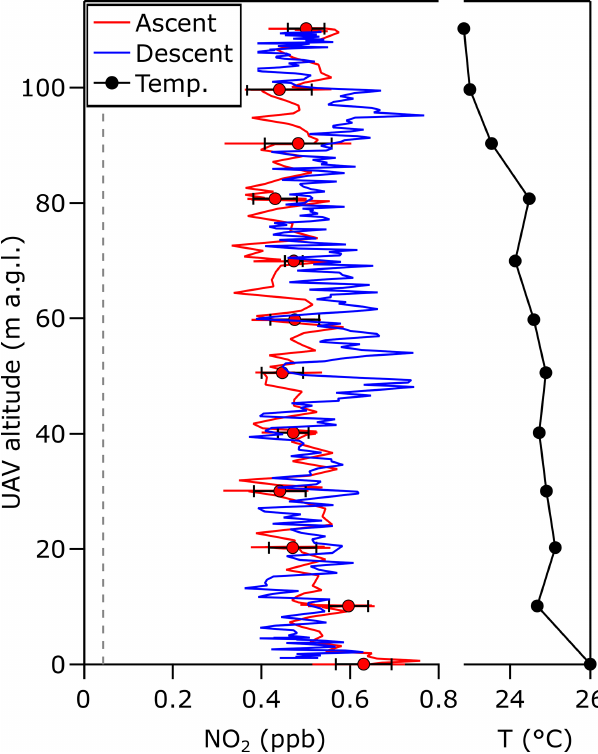
Figure 4. Vertical profiles of NO 2 during ascent (red) and descent (blue) measured during a UAV flight from 0 to 110m in Boulder, Colorado. Filled circles and bars represent the average and standard deviation for measurements acquired for 10s at each 10m height during ascent, with a 1ms − 1 ascent rate between each level leg. During descent, the drone descended at a constant rate of 0.5ms − 1 . The averaged vertical profile of ambient temperature is shown in